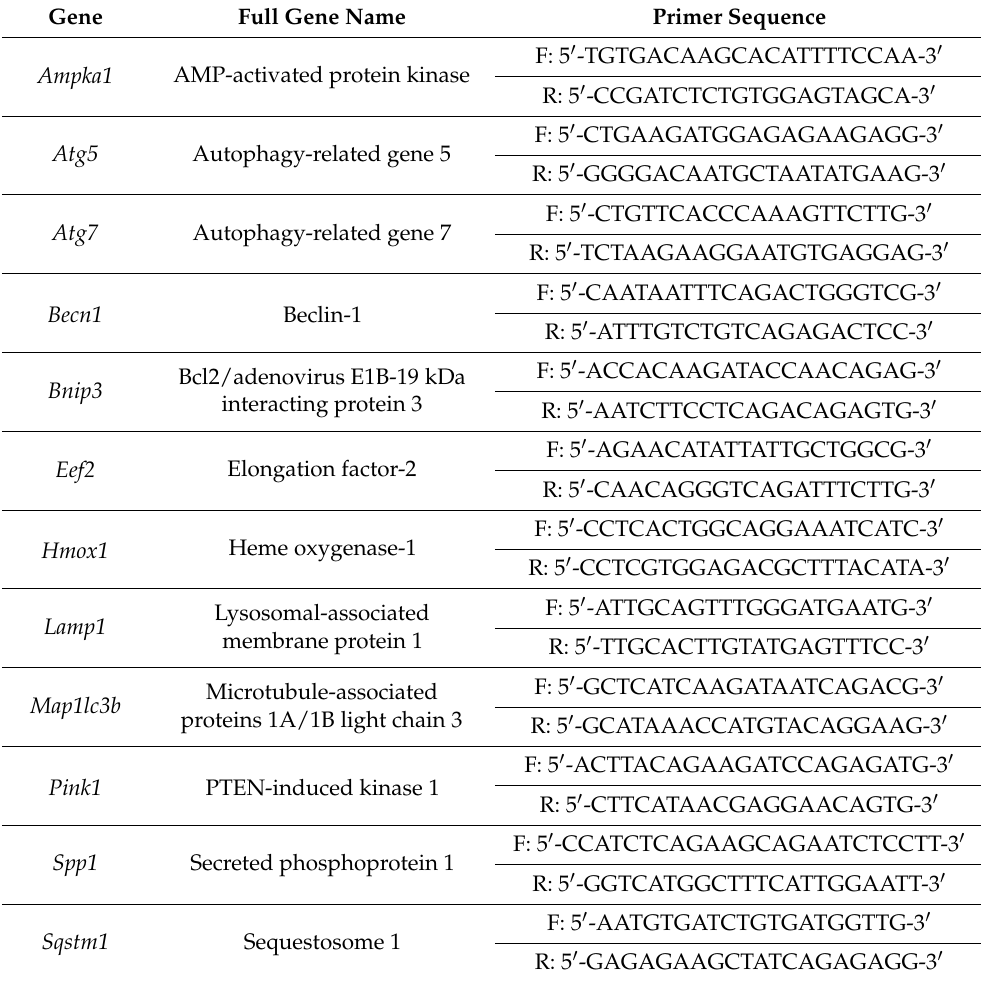
Table 1. The sequences of primers used for the determination of gene expression on mRNA level by qRT-PCR.